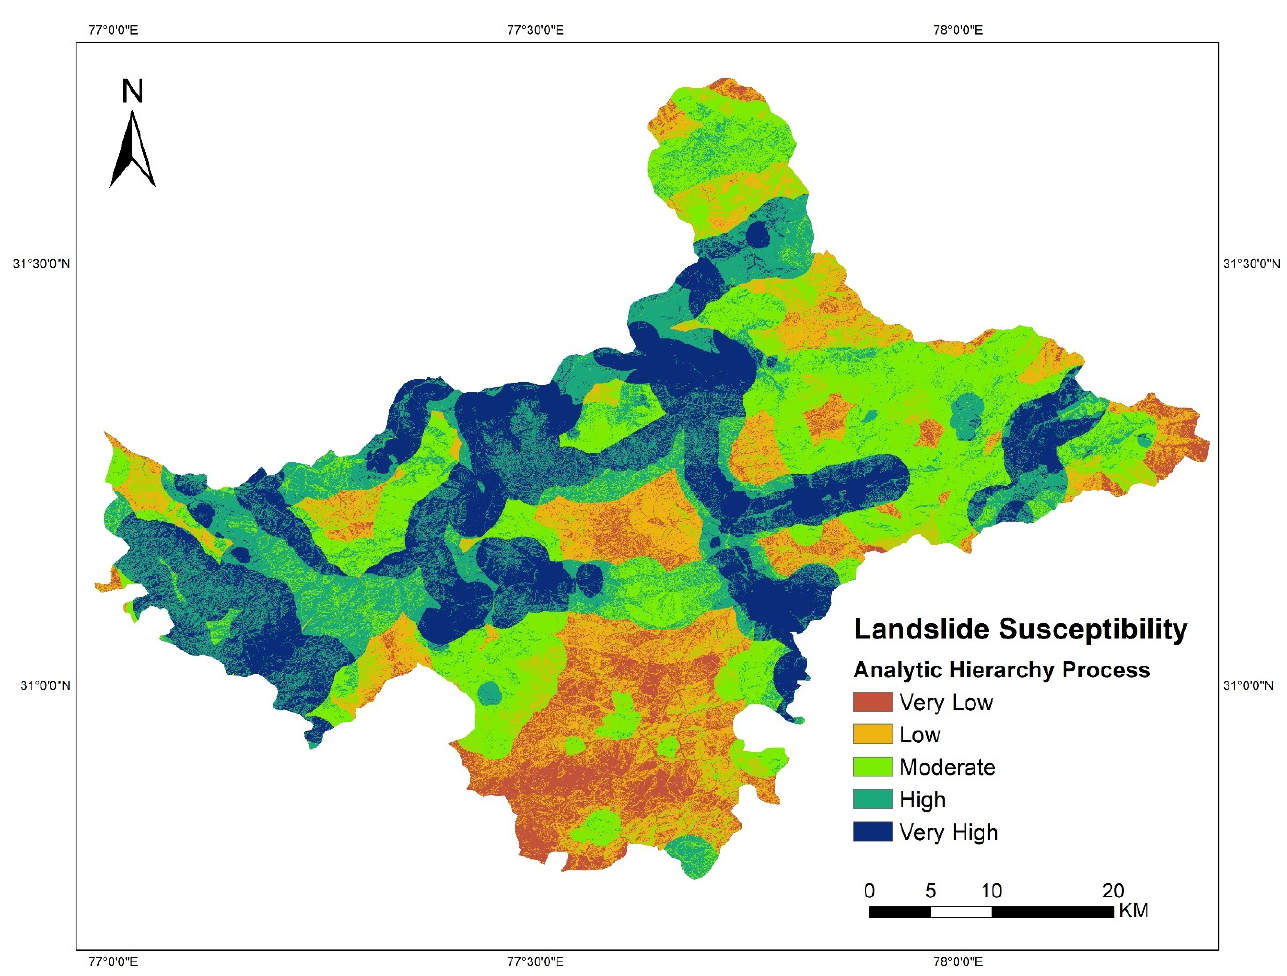
Figure 7. Landslide susceptibility map using analytic hierarchy process.